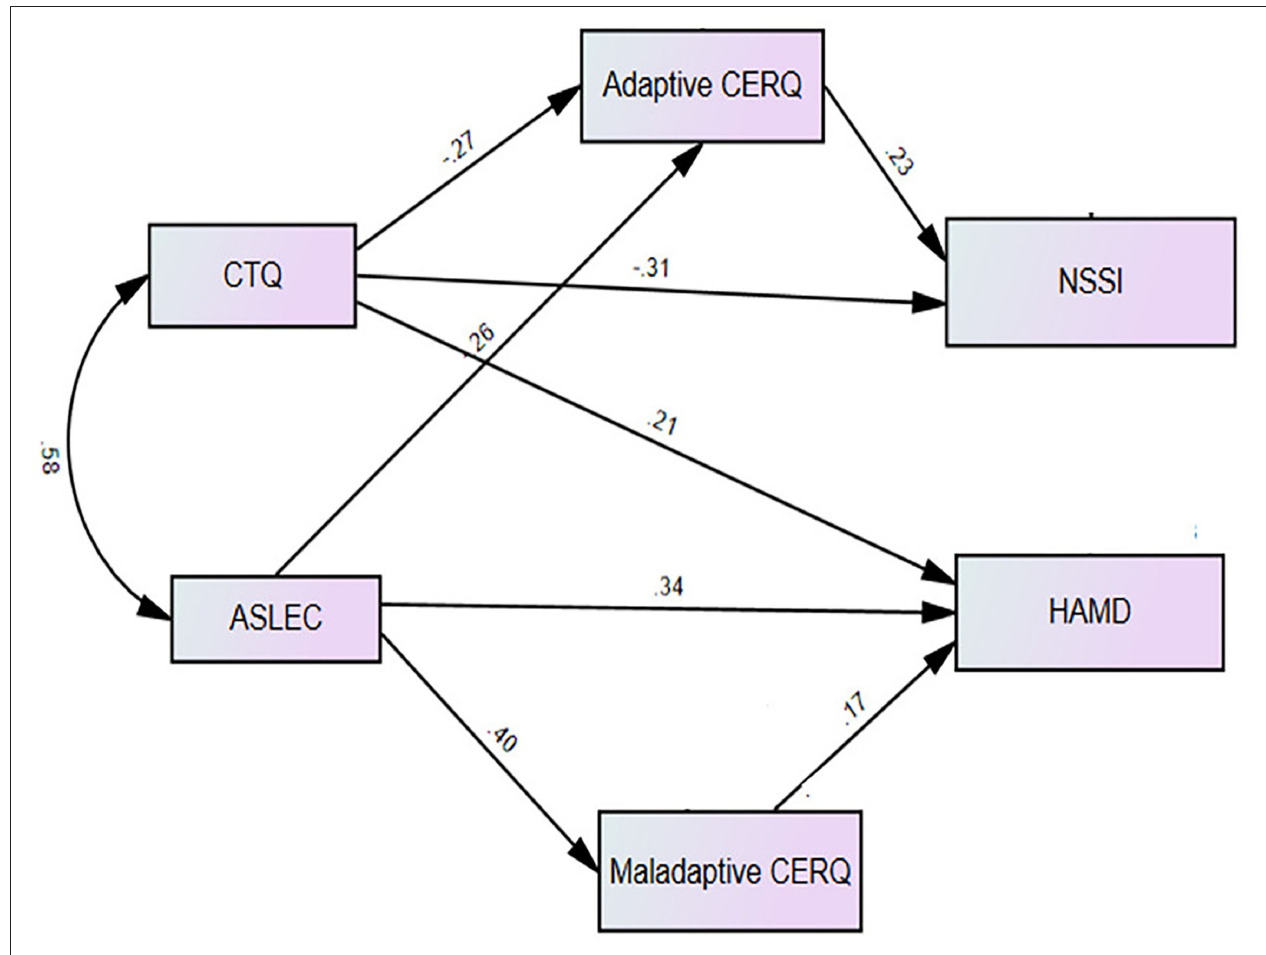
FIGURE 2 | The final model, significant standardized path coefficients on the mediating role of adaptive and maladaptive